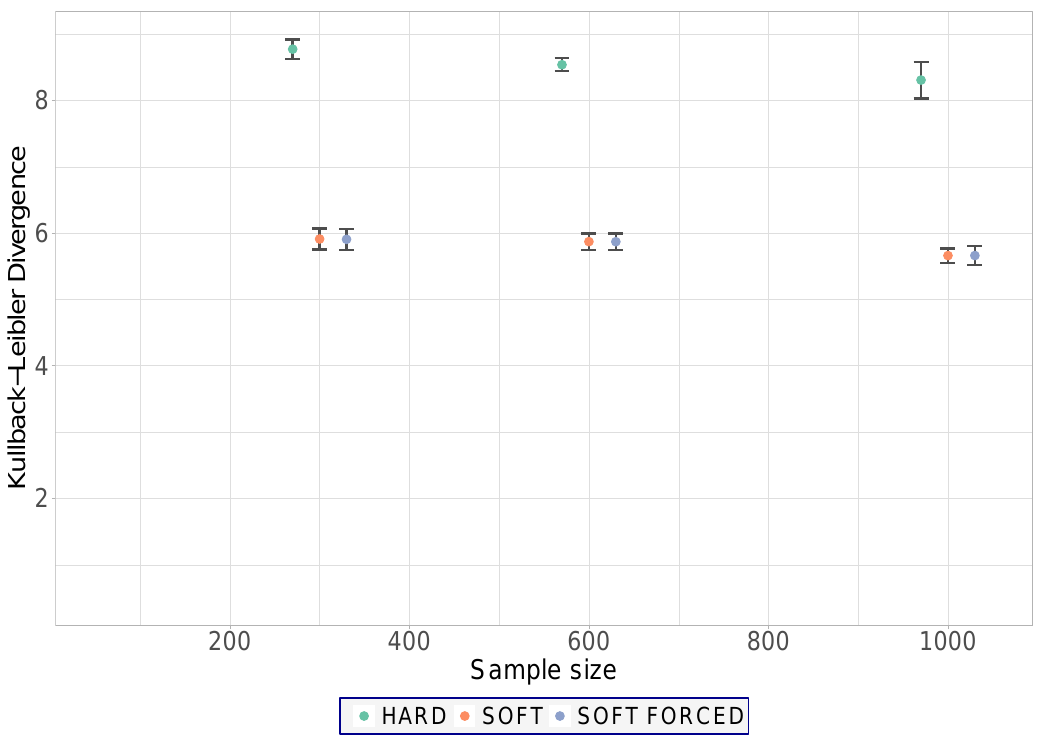
Figure 5. Leaf G. Hard EM achieves a value of KLD which is significantly greater than that achieved by other EM algorithms (data sets with 1% missing data generated from the Pathfinder